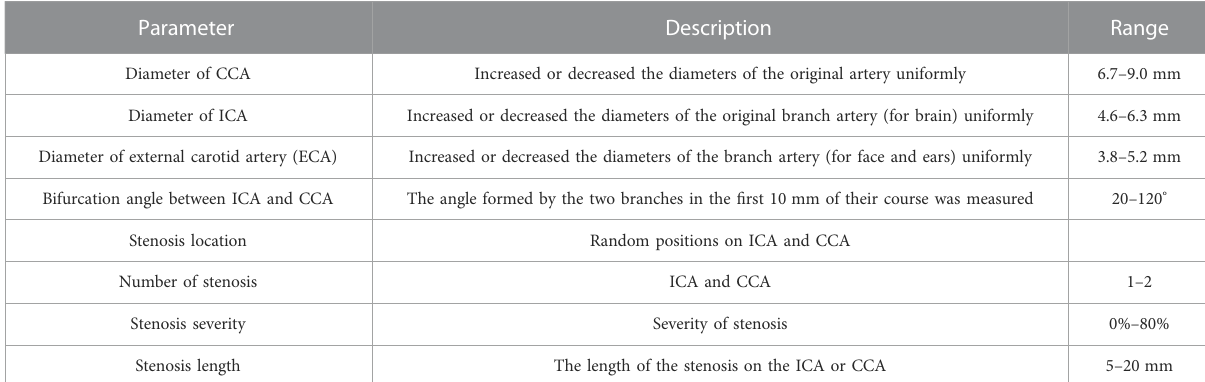
TABLE 1 Geometric parameters of carotid arteries and stenoses.